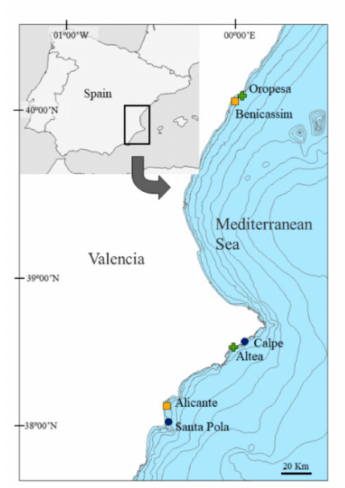
Figure 1. Map of the coast of Valencian Community (eastern Spain) with the 6 sampling locations (blue circles correspond to a high ecological status, green crosses reflect good ecological status and orange squares stand for a moderate-poor ecological